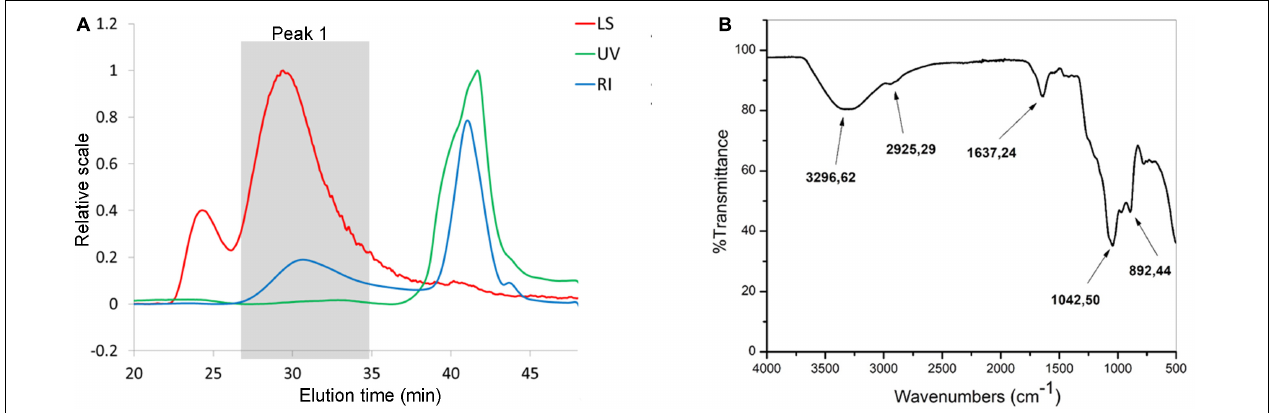
FIGURE 2 | SEC analysis (A) of EPS-AN8. Ultraviolet (UV, 280 nm) detector, multiangle light scattering (LS, angle 90 ◦ ), refraction index (RI). (B) FTIR spectra of